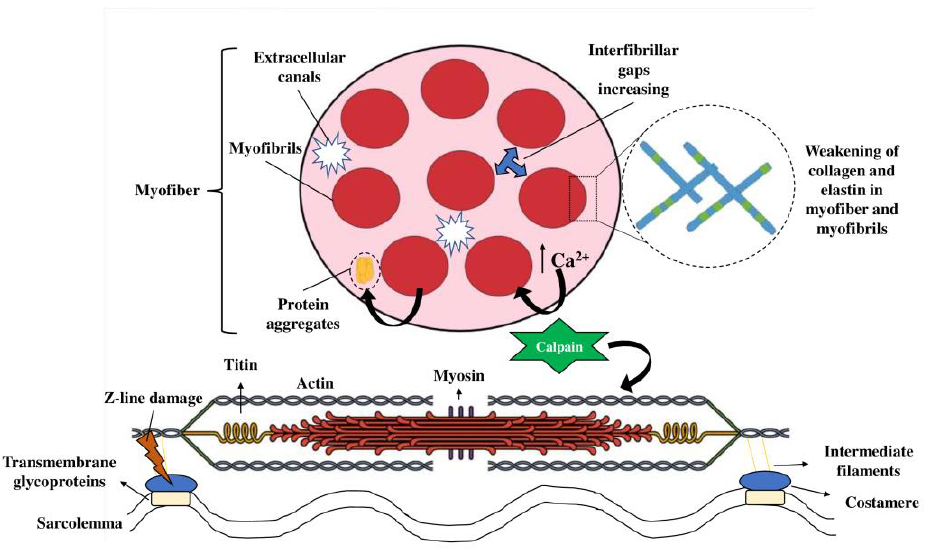
Figure 3. Schematic findings of HIUS and HPP-assisted tenderization effects at the myofibrillar level. Both cavitation and high pressure can cause the weakening of connective tissue and increase the susceptibility of muscle fibers to softening. The action of these NTTs could increase interfibrillar gaps, form extracellular canals, and originate protein aggregates due to myofibrillar degradation. Moreover, the improved releasing of calcium ions, due to mechanical stress, enhance the activation of calpains and other proteases, damaging myofibrillar proteins, such as actin and myosin, and also causing fractures in the Z-line.